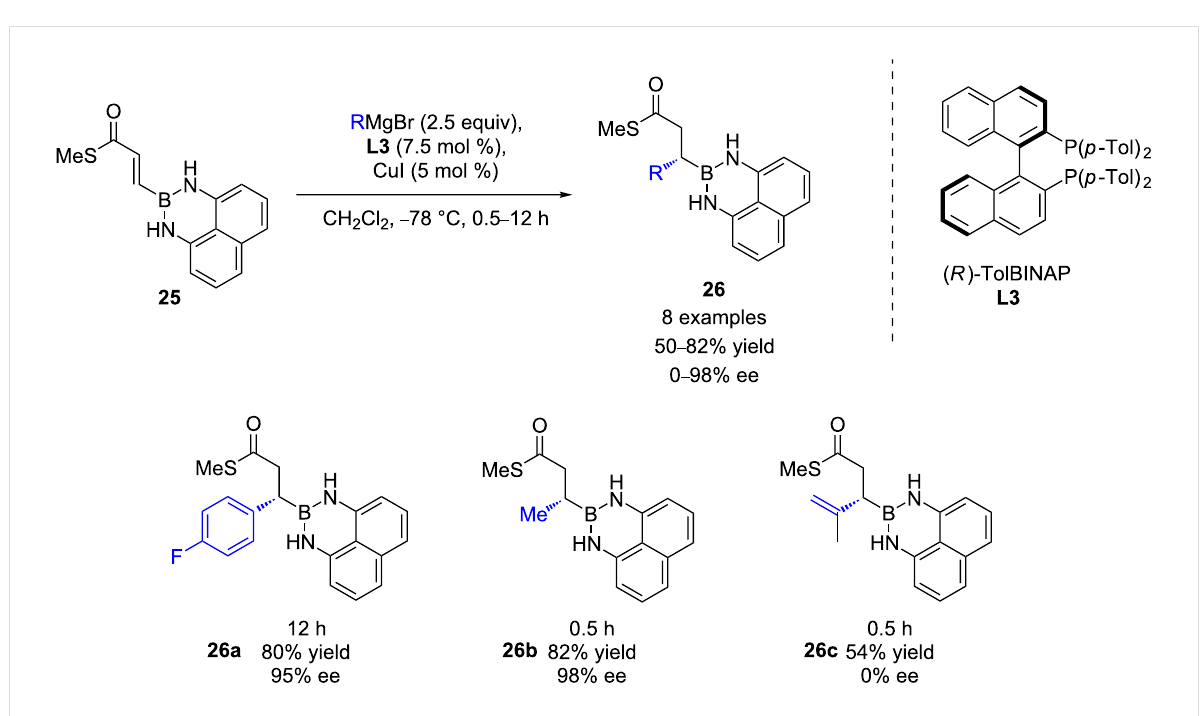
Scheme 11: Cu ECA of Grignard reagents to 3-boronyl α , β -unsaturated thioesters.